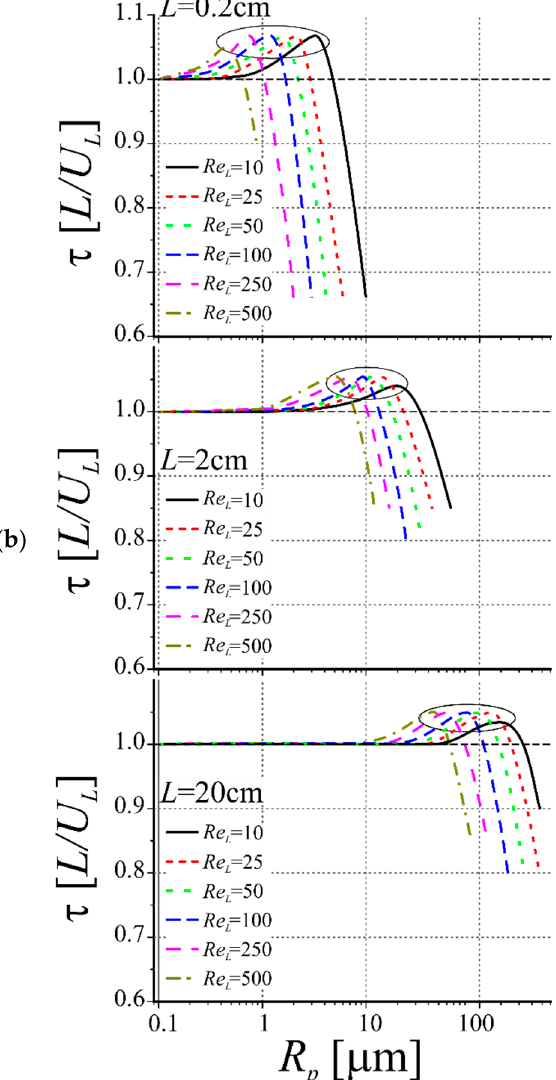
Figure 4. Residence times of the particles against the radii τ ( R p ): ( a ) for L = 0.2 cm and Re L = 25; ( b ) for three values of L (0.2, 2, and 20 cm) and various intensities of the BL flow ( Re L = 10, 25, 50, 100, 250, and 500).